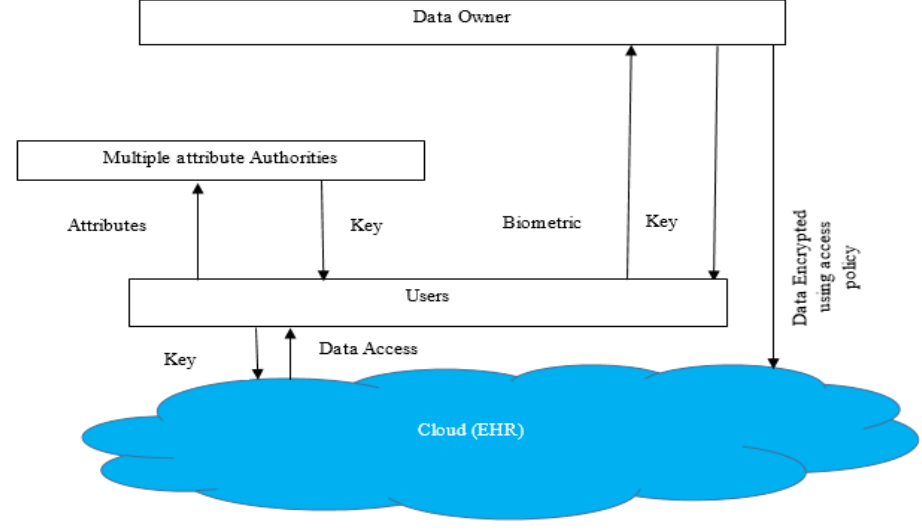
Figure 1. The proposed biometric based multi-authority IPE